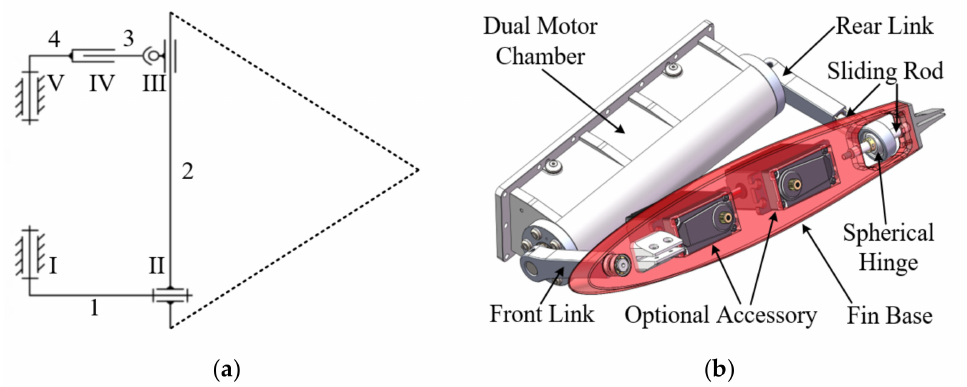
Figure 4. Multi-DOF bionic propelling mechanism. ( a ) Scheme of the spatial parallel mechanism; ( b ) diagram of the propelling module